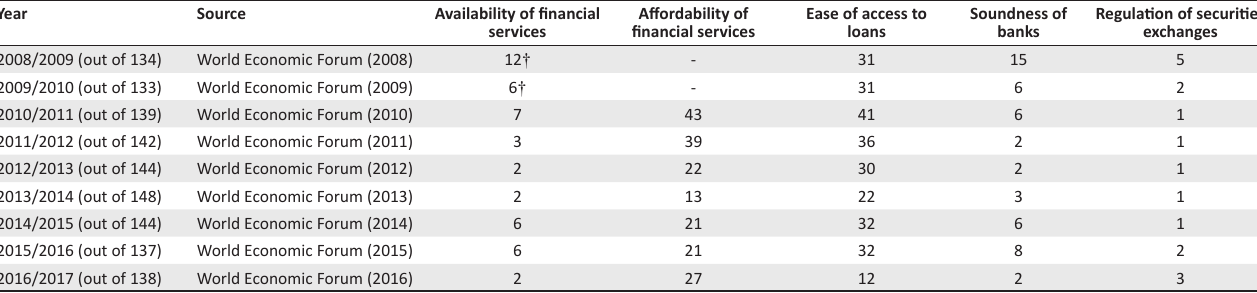
TABLE 2: The global competitiveness of the South Africa’s banking industry.